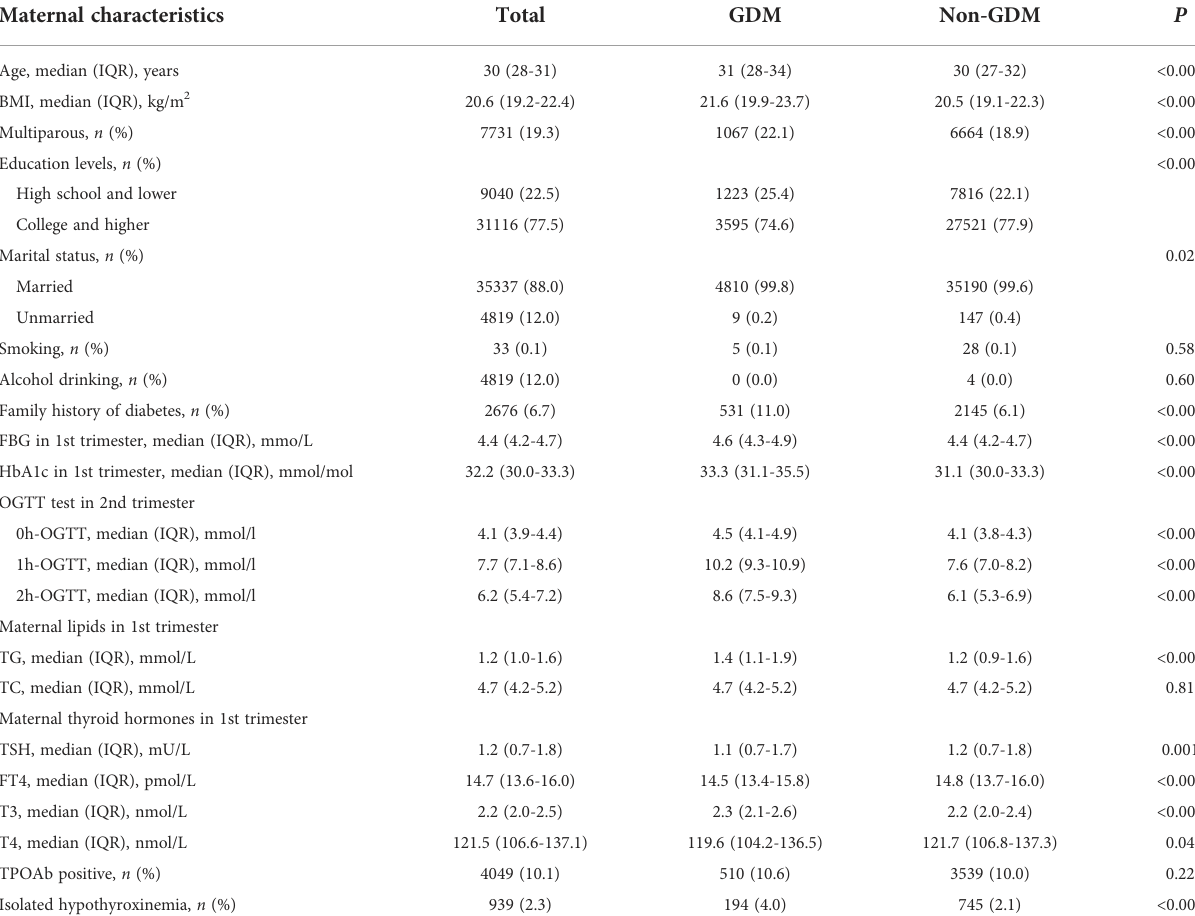
TABLE 1 Demographic characteristics of the study population. Maternal